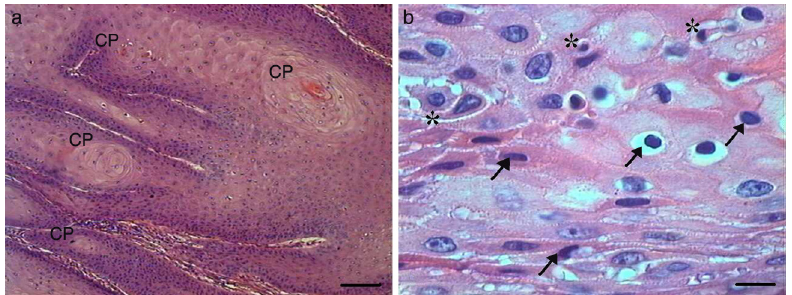
Figure 1 Grade I squamous cell carcinoma (A) Micrograph of grade I squamous carcinoma cells, with the presence of diffuse keratin pearls (CP) (HE, bar = 100 (cid:2) m). (B) Micrograph of grade I squamous carcinoma cells with various apoptotic cells with condensation of cytoplasm (arrows) and anoikis (*) (HE, bar = 10 (cid:2) m). of fields (100 × objective) was analyzed and the number of total NORs ( i.e. , the number clumps per nucleus in the field divided by the total number of nuclei in that same field, using the same method and equipment mentioned above) was registered. The stabilization occurred when 10 fields per slide for papillomas and 15 slides for all grades of carcinomas were achieved.